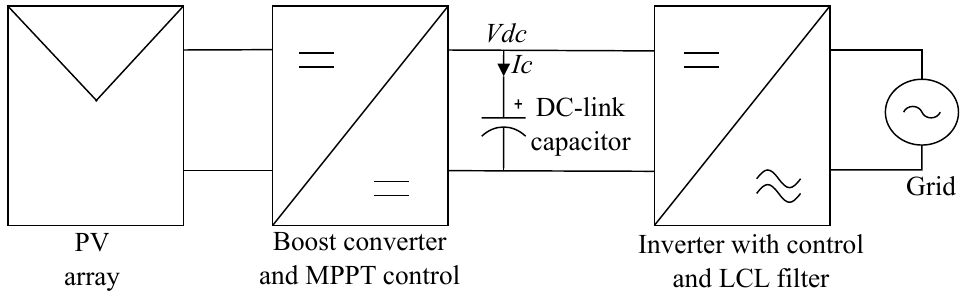
Figure 5. Grid-connected single-phase PV system.